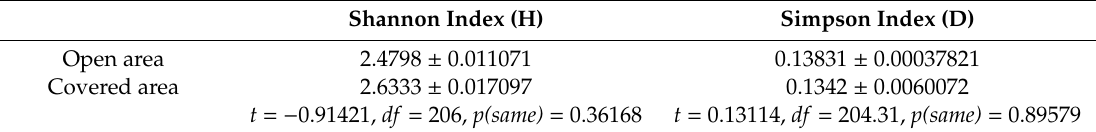
Table 5. Ant Diversity t